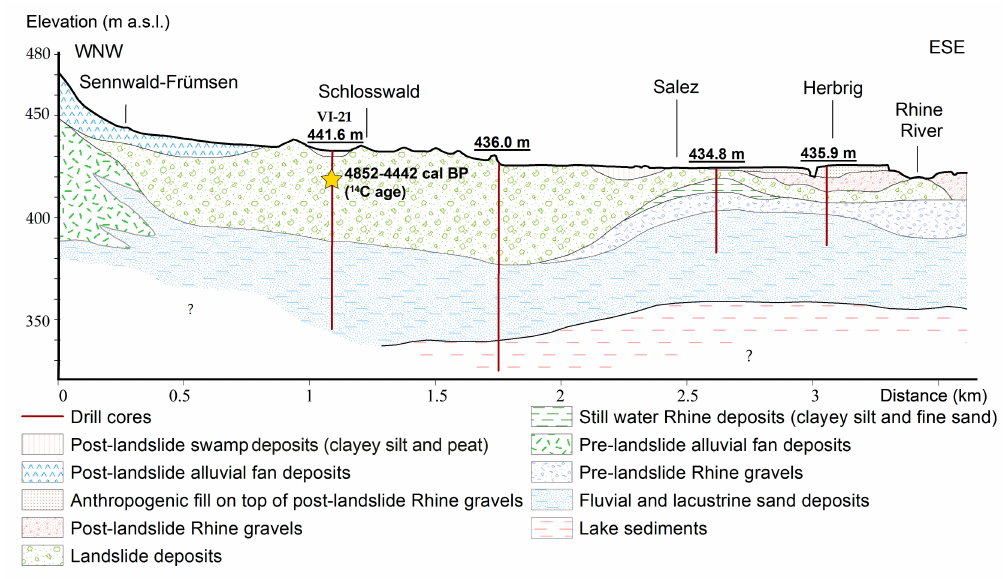
Figure 7. Cross section of the landslide deposition area. Cross section line (B-B (cid:48) ) and boreholes are shown in Figure 5. Modified after